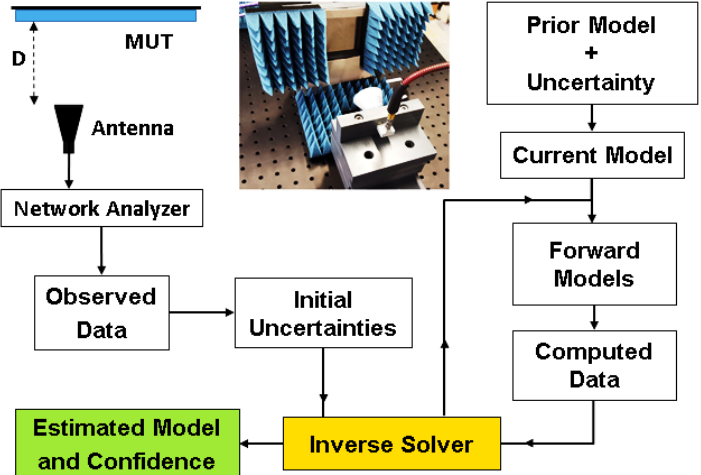
Figure 1. Bayesian inversion procedure after scattering parameters